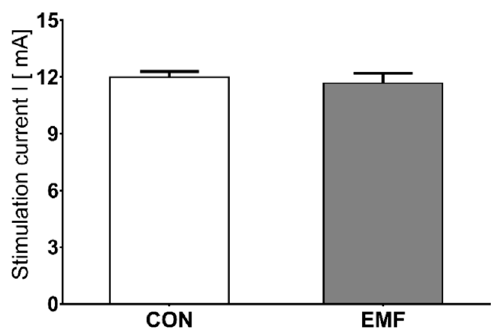
Figure 7. The threshold stimulation in the control group (CON) and EMF-exposed group (EMF). The data are expressed as mean values ± SEM.